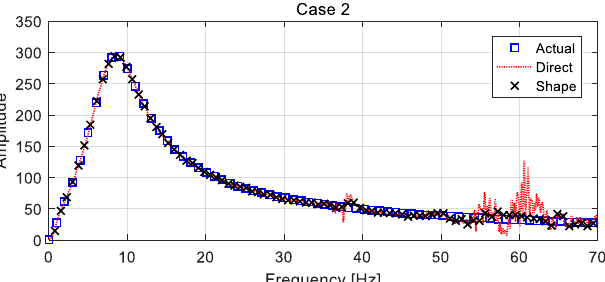
Figure 13. Comparison of the amplitudes of the vehicle acceleration FRF along DOF u 1 in Case 2.